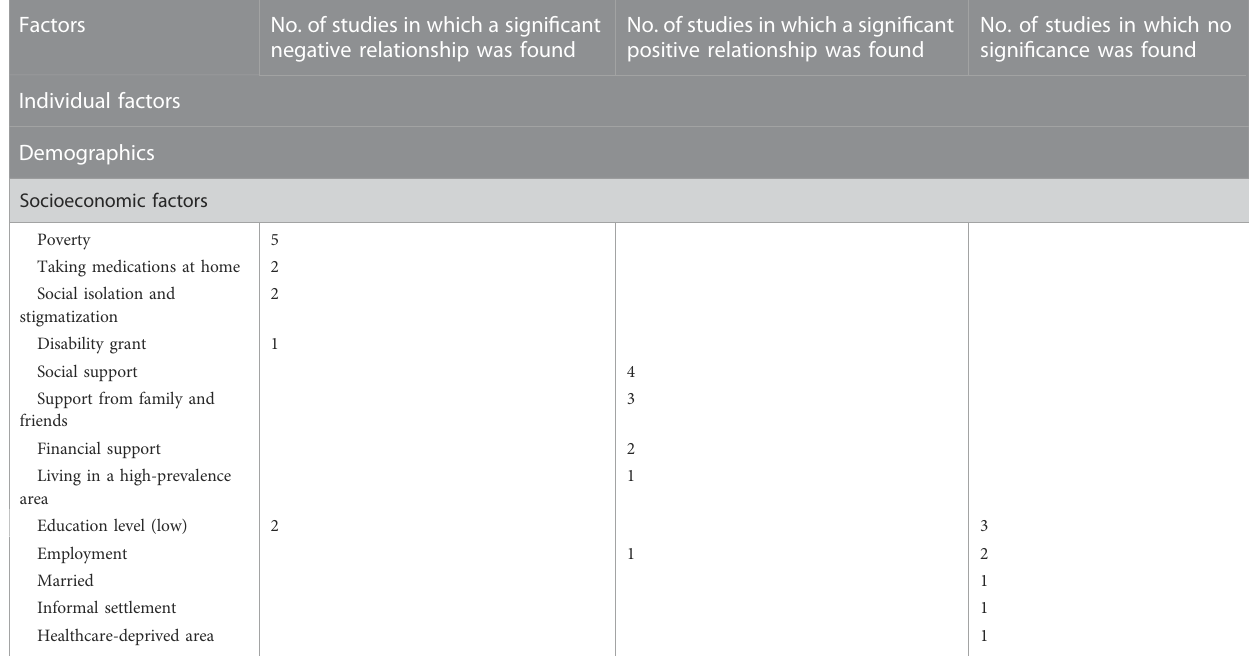
TABLE 2 ( Continued ) Five categories of factors affecting polypharmacy adherence in